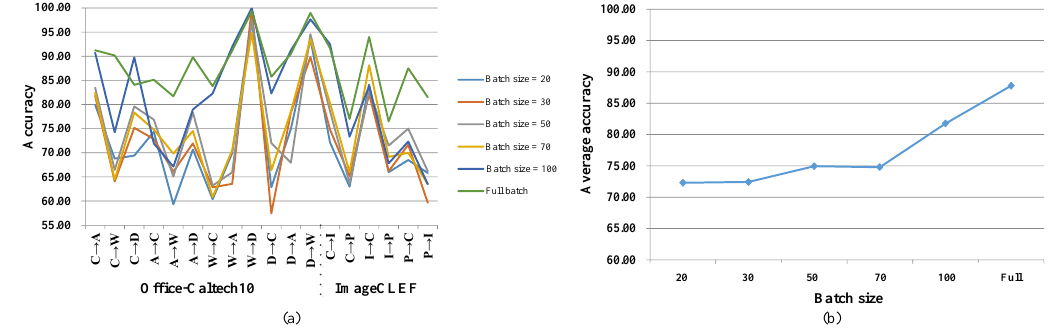
Figure 6. Experiments with different batch sizes. ( a ) Accuracy (%) on every subtask with different batch sizes. ( b ) Average accuracy (%) with different batch